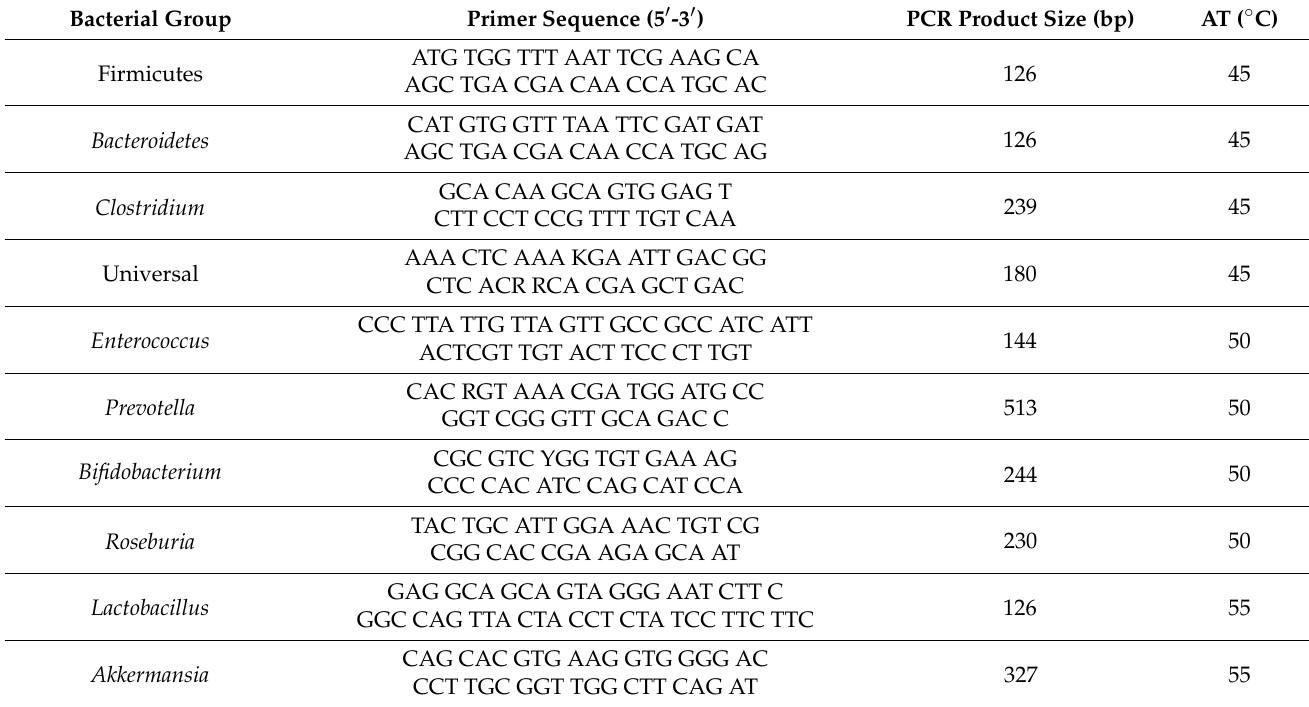
Table 1. Primer sequences and real-time PCR conditions used for gut microbiota analysis. Bacterial Group Primer Sequence (5 (cid:48) -3 (cid:48) ) PCR Product Size (bp) AT ( ◦